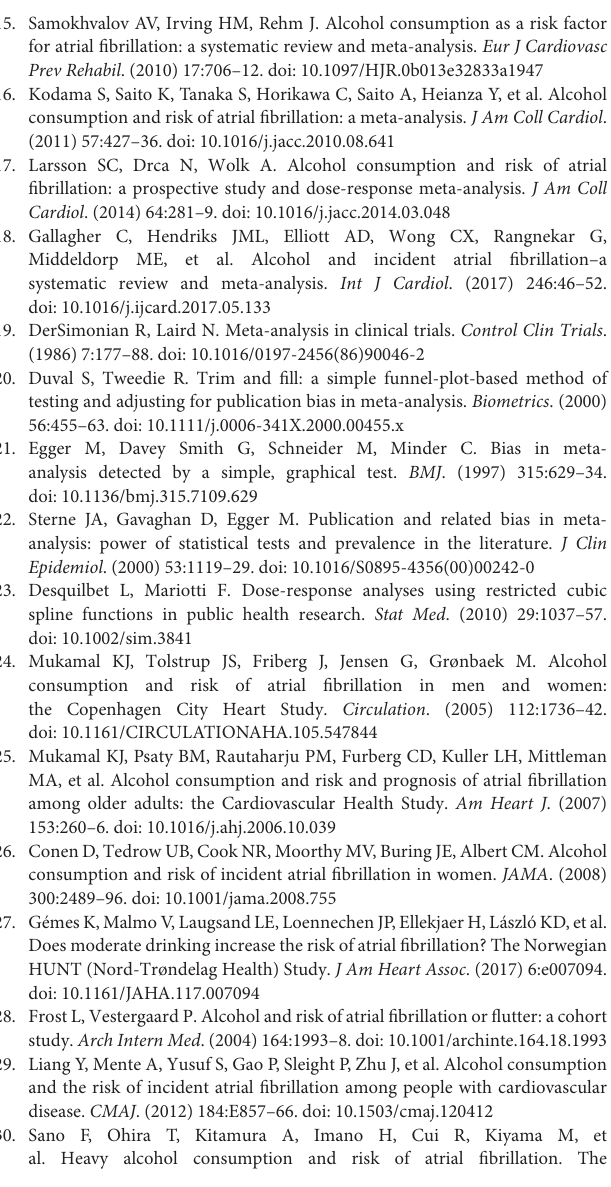
Supplementary Figure 1 | Funnel plots for alcohol consumption and AF. (A) high alcohol intake, filled; (B) moderate alcohol intake, filled; (C) low alcohol intake. Supplementary Figure 2 | Sensitivity analysis using the one-study removal method. (A) high alcohol intake; (B) moderate alcohol intake; (C) low alcohol